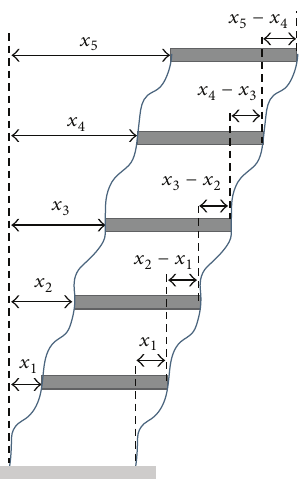
Figure 2: Displacement and relevant displacement of the floors.